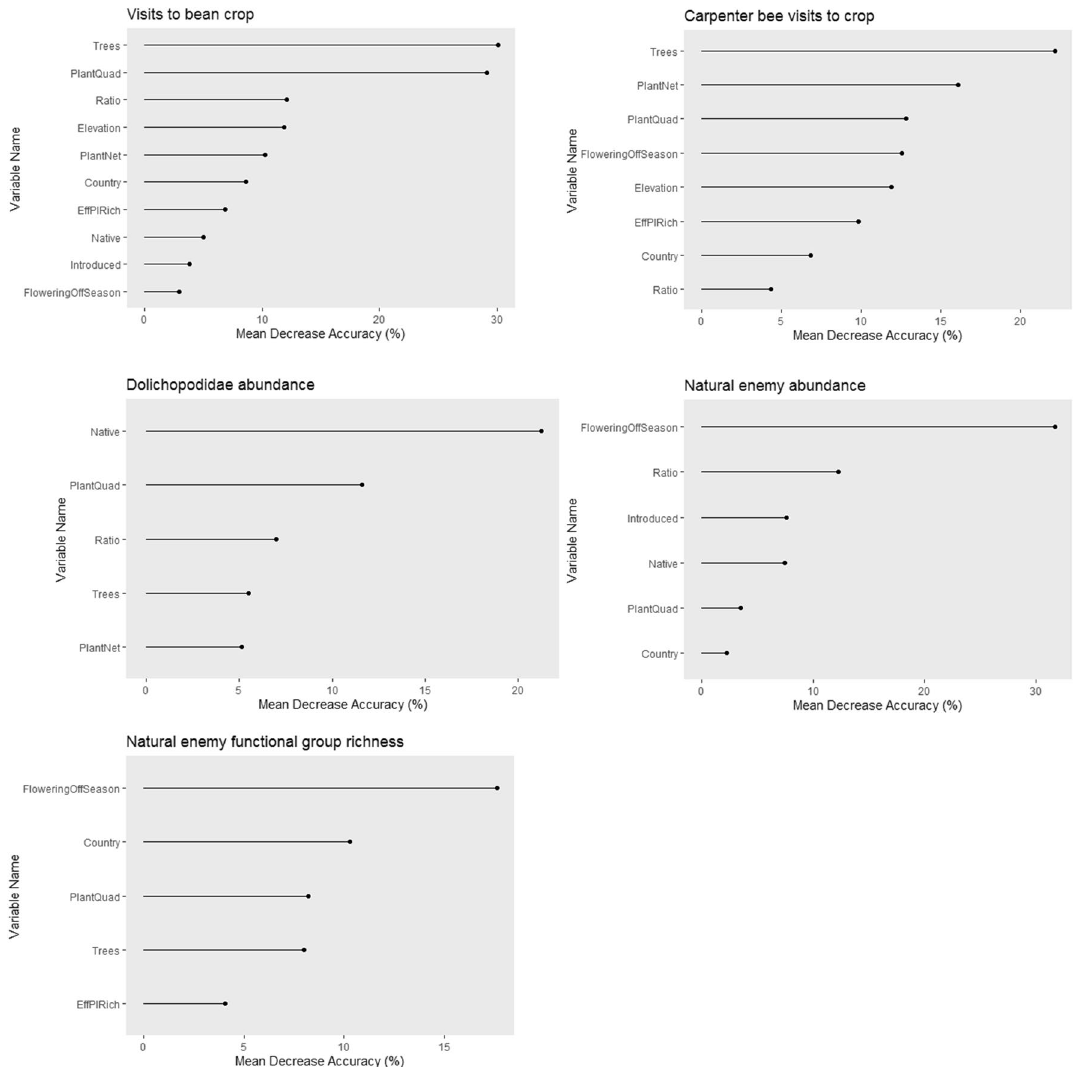
Figure 1. Variable importance plots showing the predictive power of different botanical and site variables on measures of beneficial insect abundance, diversity and activity, as calculated by the random forest models. Mean decrease accuracy indicates the amount by which the model predictive accuracy decreases if a given variable is excluded. Created in R 29